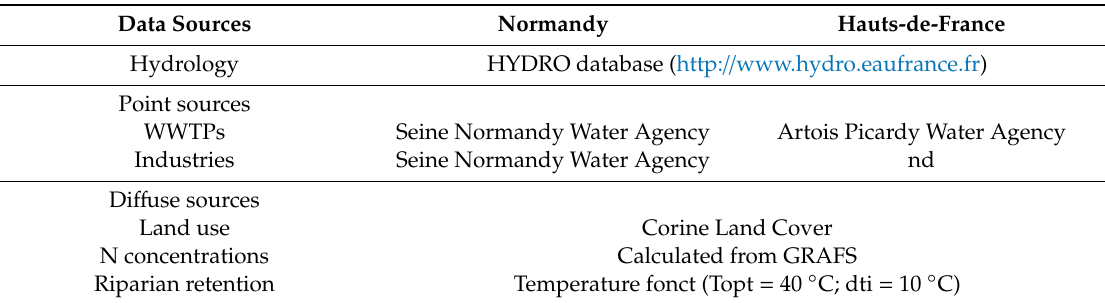
Table 1. Constraints taken into account by the RIVERSTRAHLER model for calculating nutrient flows at the outlets of the main rivers of the Normandy and Hauts-de-France coastal zones.